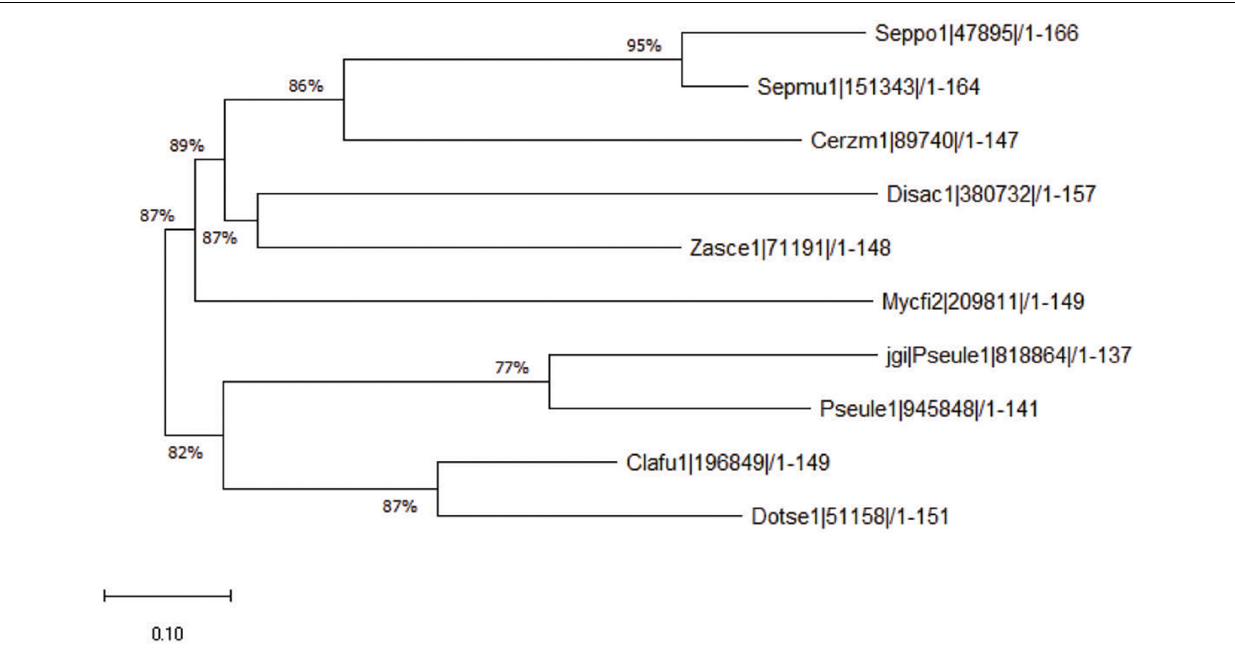
FIGURE 2 | Phylogenetic tree of Ecp20-2 orthologs. The phylogenetic tree resents the similarity of Ecp20-2 amino acid sequence with 9 other orthologs found in the other Dothedeomycetes. Amino acid sequences encoded by orthologous genes were aligned using ClustalW, and the phytogenic tree was constructed by neighbor-joining method in MEGA X. Clafu1, Dotse1, Pseule1, Mycfi2, Zasce1, Disac1, Cerzm1, Sepmu1, and Seppo1 stands for orthologous genes from fungi Cladosporium fulvum v1.0, Dothistroma septosporum v1.0, Pseudocercospora ulei v1.0, Mycosphaerella fijensis v2.0, Zasmidium cellare v1.0 Dissoconium aciculare v1.0, Cercospora zeae-maydis v1.0, Septoria populicola v1.0, and Septoria musiva v1.0, respectively. Numbers show the percentage of similarity between two orthologous